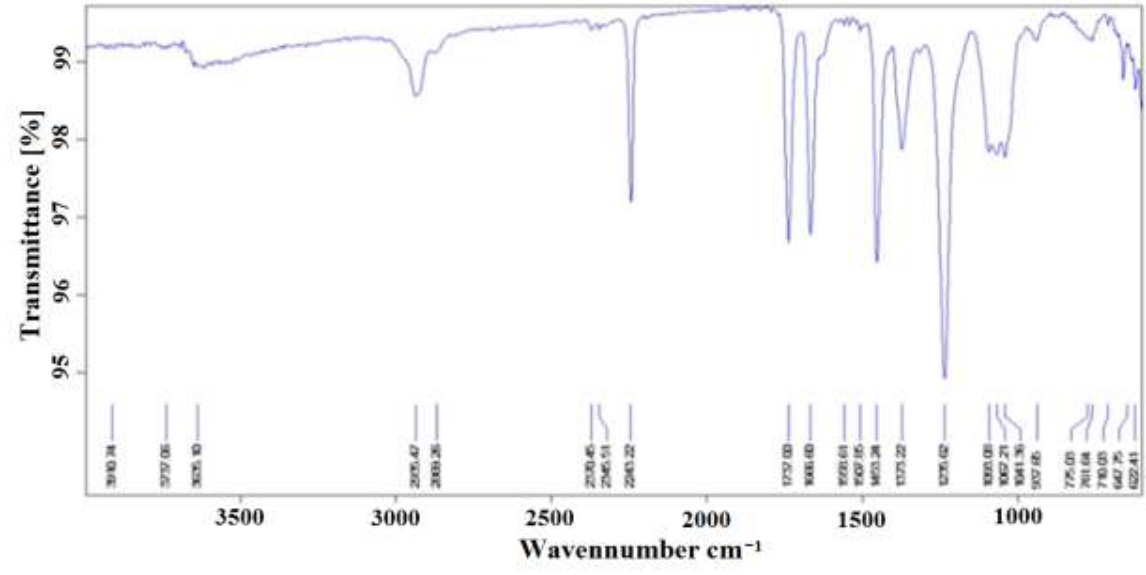
Figure 11: FTIR analysis of the prepared 12wt.% air nanofilter.